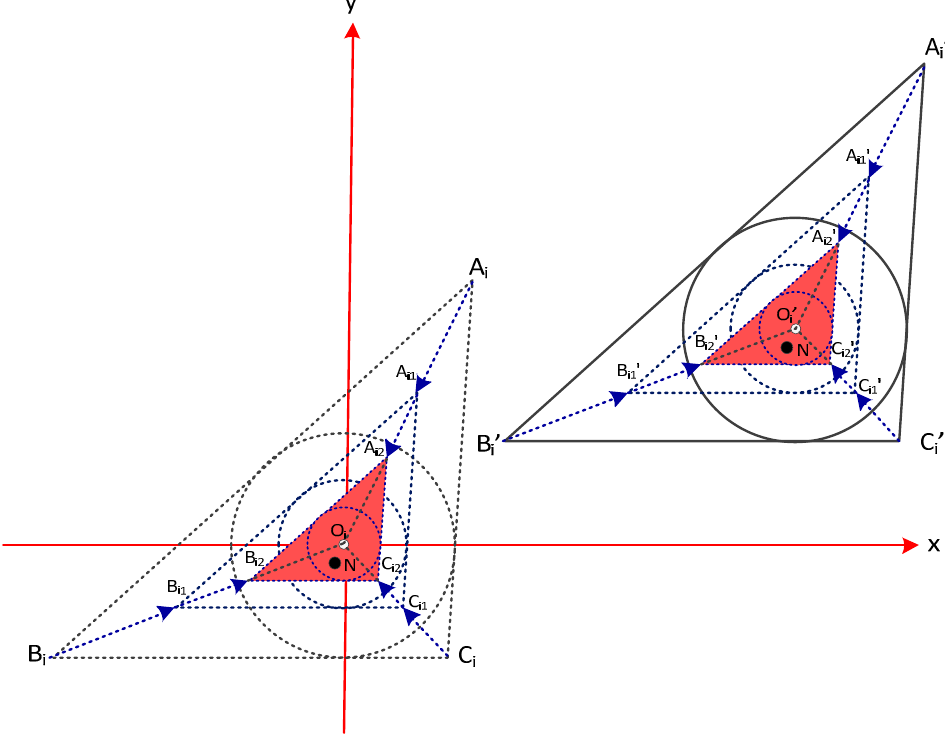
Figure 9. The main principle of HTCRL localization algorithm.